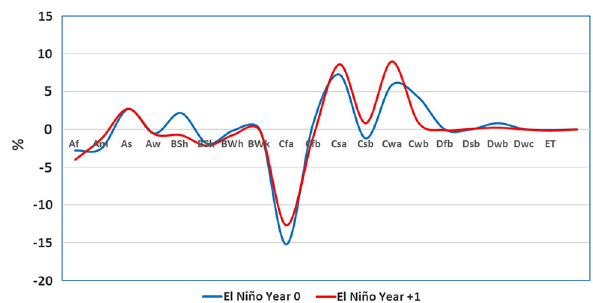
Fig. 4 Comparison of spatial coverage of changes (%) in climate subtypes in response to El Nin˜o in Year 0 and Year ? 1 based on five strong El Nin˜os